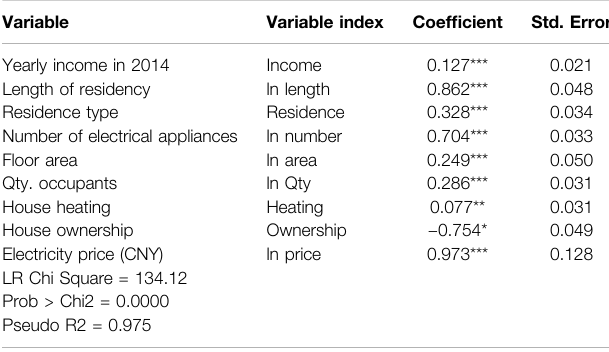
TABLE 2 | Effect factors of electricity